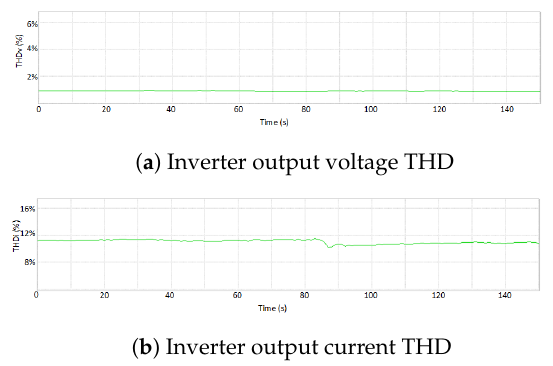
Figure 21. Voltage and current total harmonic distortion (THD) level.